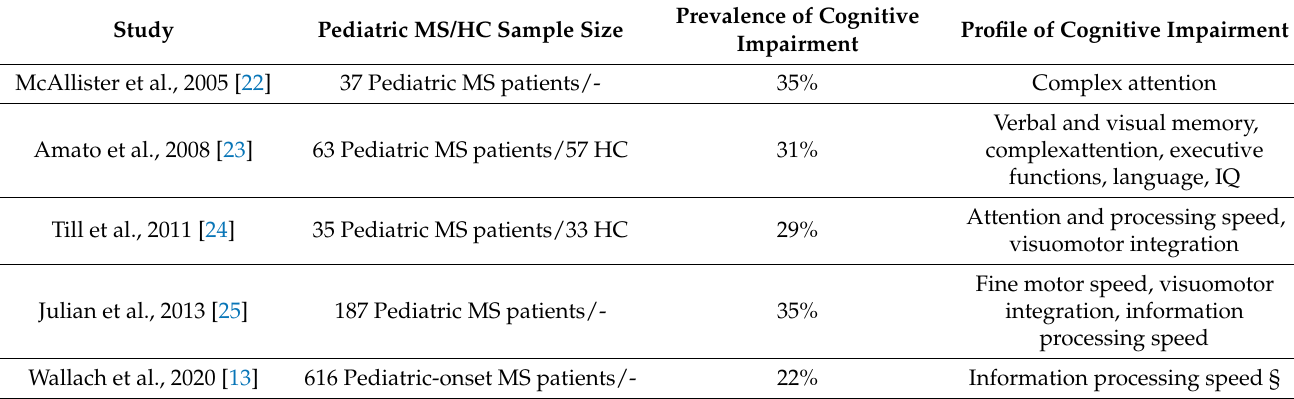
Table 1. Main cross-sectional studies * on cognitive impairment in pediatric multiple sclerosis patients.